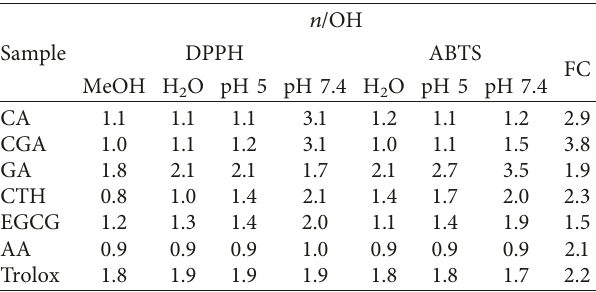
Figure 1: The number of exchanged electrons per molecule of caffeic acid (CA), chlorogenic acid (CGA), gallic acid (GA), catechin (CTH), epigallocatechin gallate (EGCG), ascorbic acid (AA), dehydroascorbic acid (DHA), and Trolox in DPPH, ABTS, and FC assays. Numbers of exchanged electrons were determined after 60min incubation of antioxidant with the probe at 25 ° C in the appropriate solvent. Table 2: Number of exchanged electrons ( n ) per OH group in different antioxidant